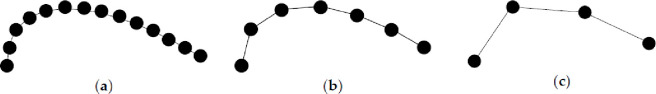
Point clouds of different densities.(a) The original dense point cloud; (b) the filtered point cloud; (c) the over-filtered point cloud.